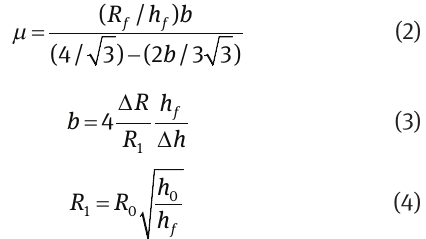
Fig. 1: Microstructure of as-cast 7005 aluminum alloy.